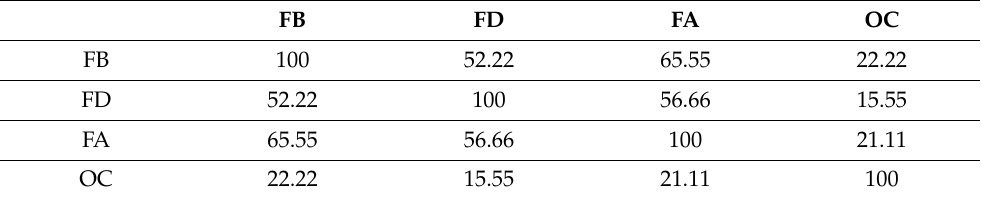
Table 1. Similarity (%) matrix of keywords of FB, FD, FA, and